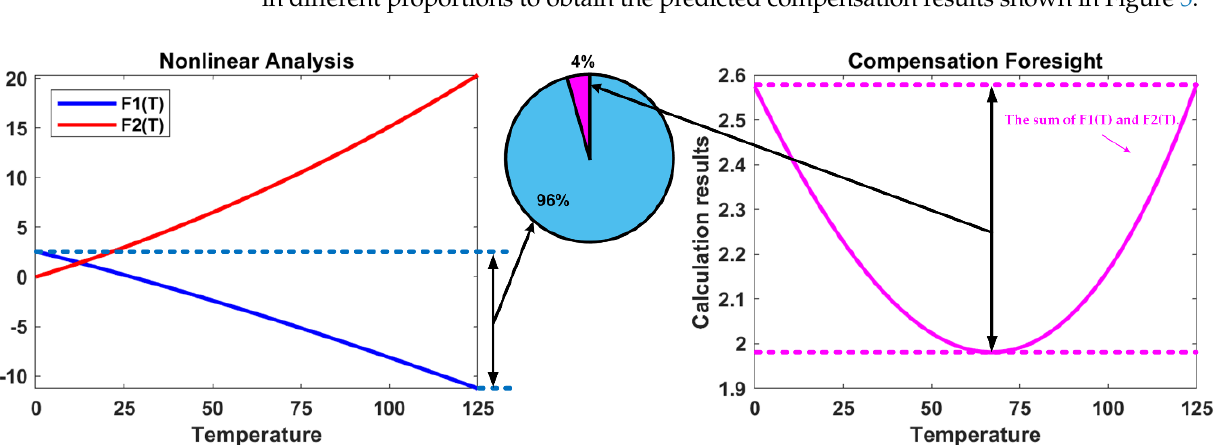
Figure 5. Ideal results calculated for the proposed curvature compensation. F 1 (T) after compensating for F 2 (T) is only 4% of that before compensation, which better suppresses the nonlinear term in V EB and realizes curvature